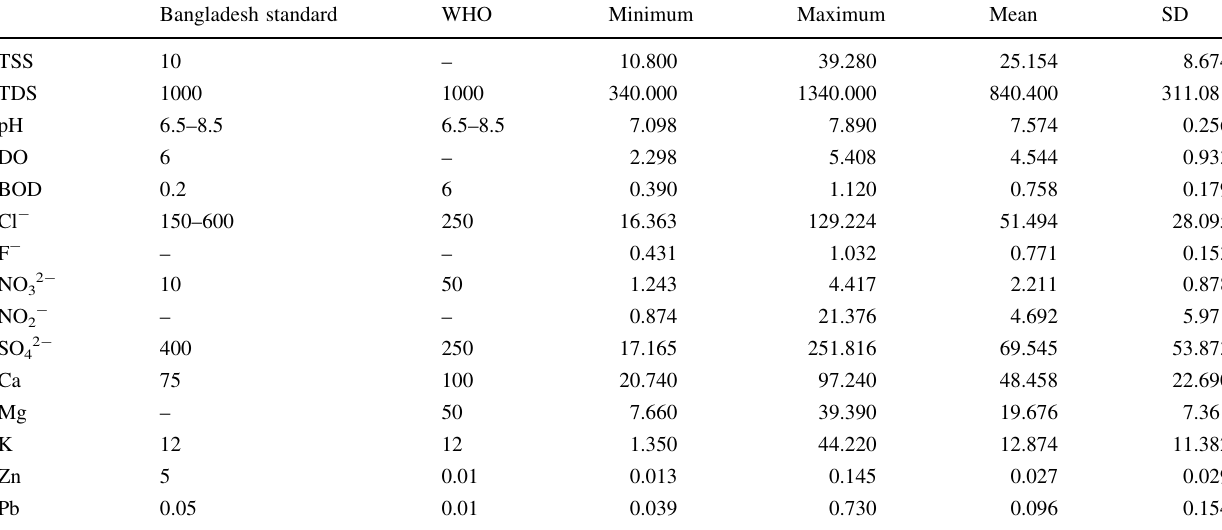
Table 2 Descriptive statistics of surface water quality